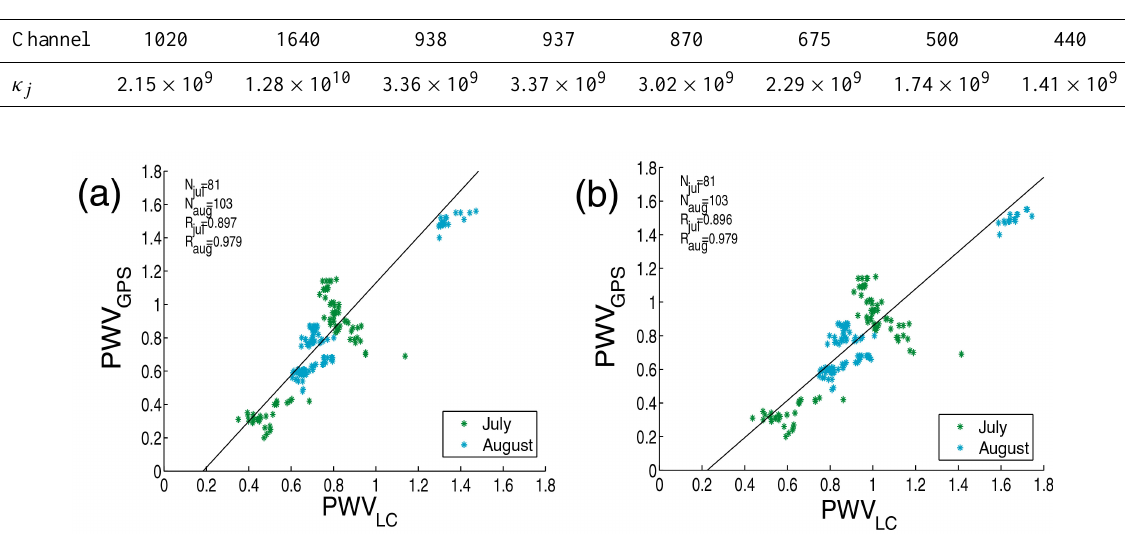
Table 2. κ j calibration coefficients (W − 1 m 2 nmDC) extracted for each LC channel obtained during the moonset of 9 February 2012.